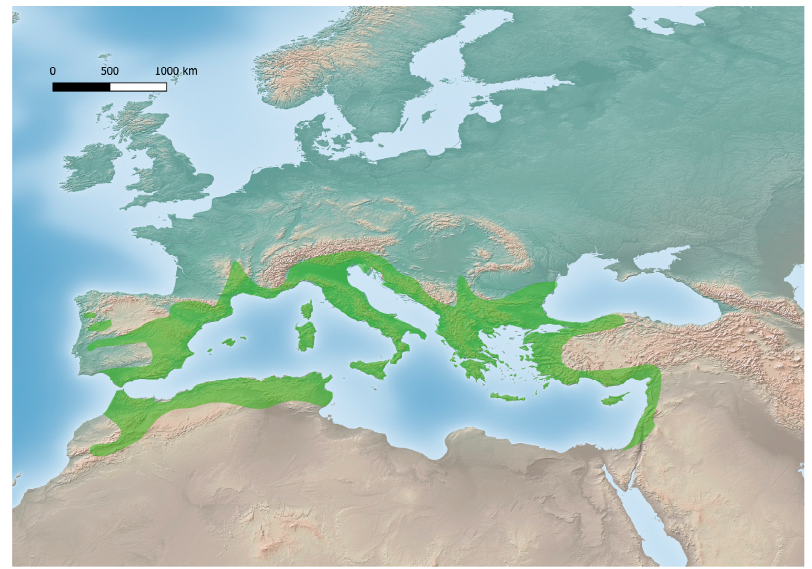
Figure 1. Current distribution of Celtis australis (redrawn from Ref [15] using QGIS version 3.4.13; Source: Natural Earth Data).